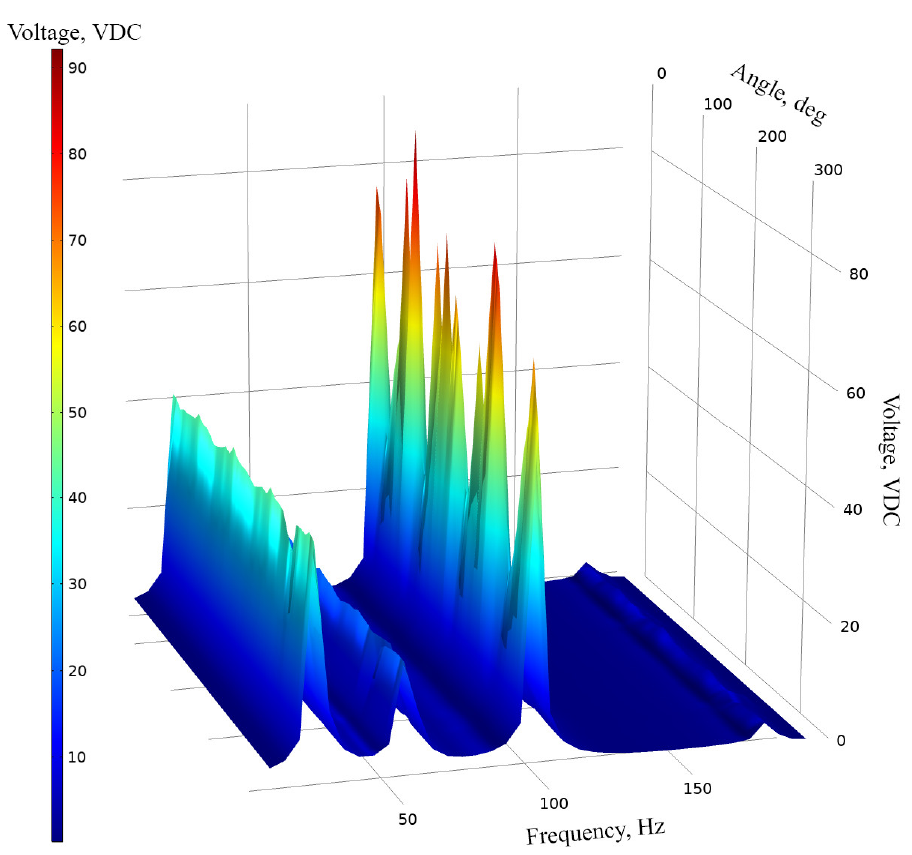
Figure 4. Open-circuit voltage characteristic of energy harvester.